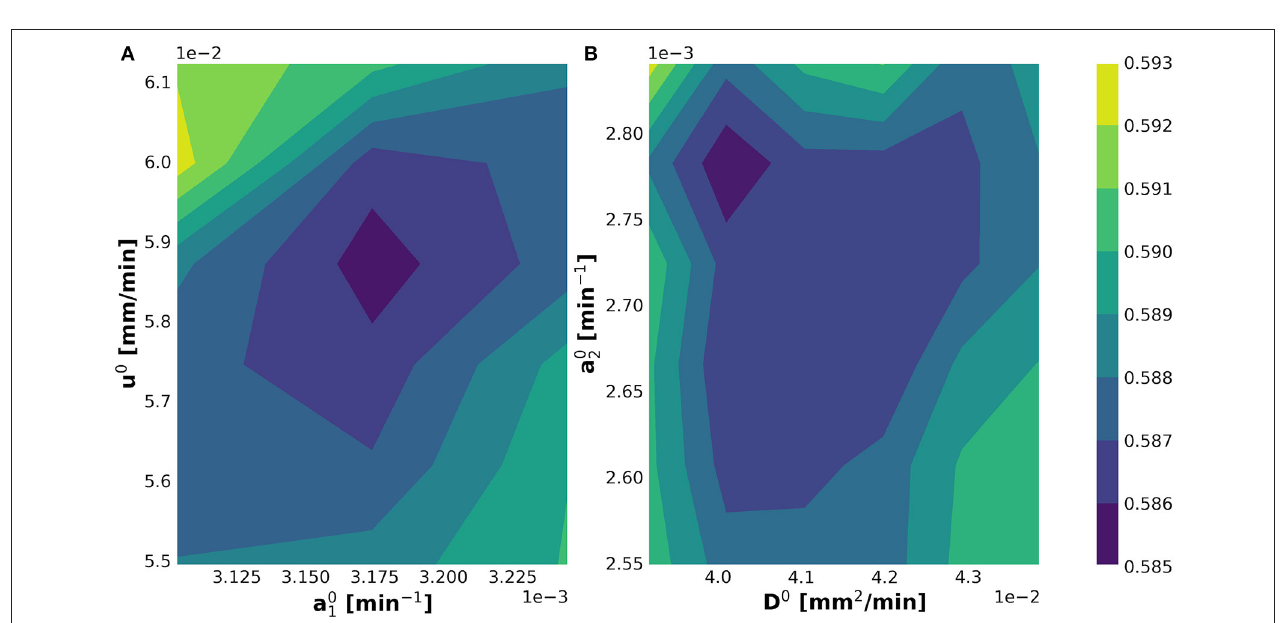
FIGURE 4 | Determination of the minimum of the optimization discrepancy functional in Equation (11) shown in the u 0 − a 0 1 (A) and a 0 2 − D 0 (B) planes.